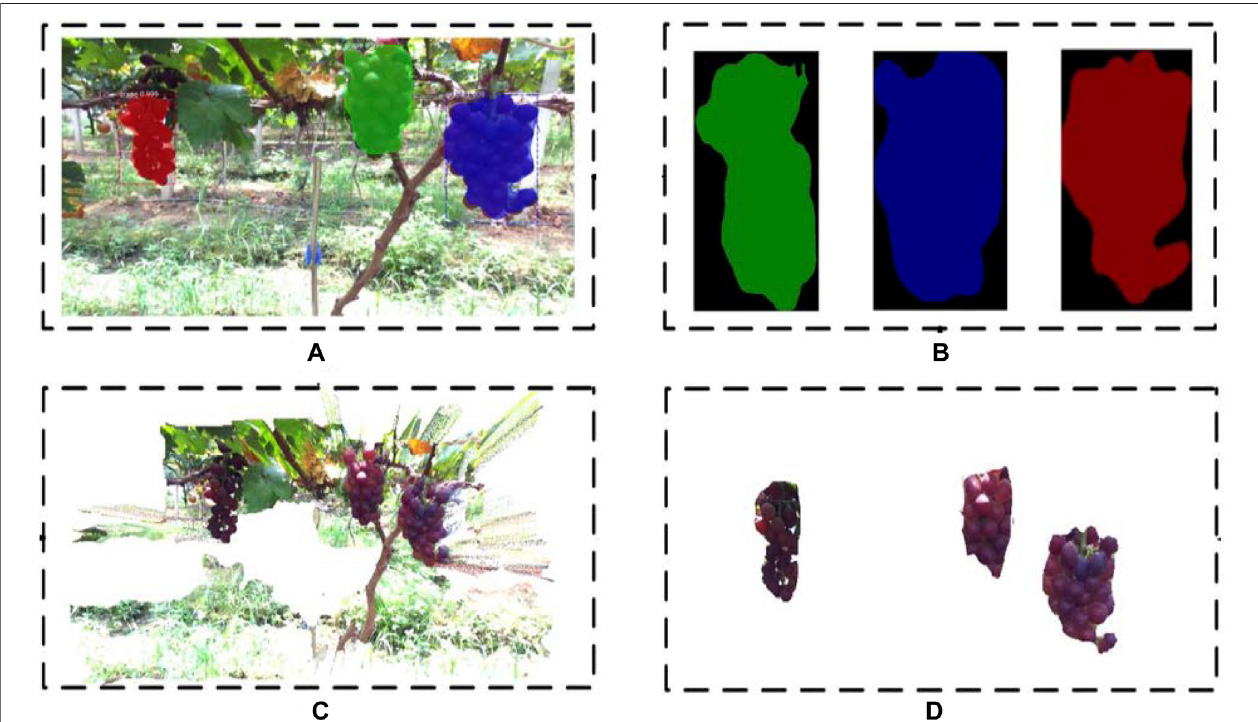
FIGURE5| Grapepointcloudsegmentation. (A) ResultofMaskR-CNNonagrapeimage, (B) binaryimagesofgrapes, (C) initialpointcloudfromthevineyard,and (D) grape point cloud segmented from the initial point cloud.